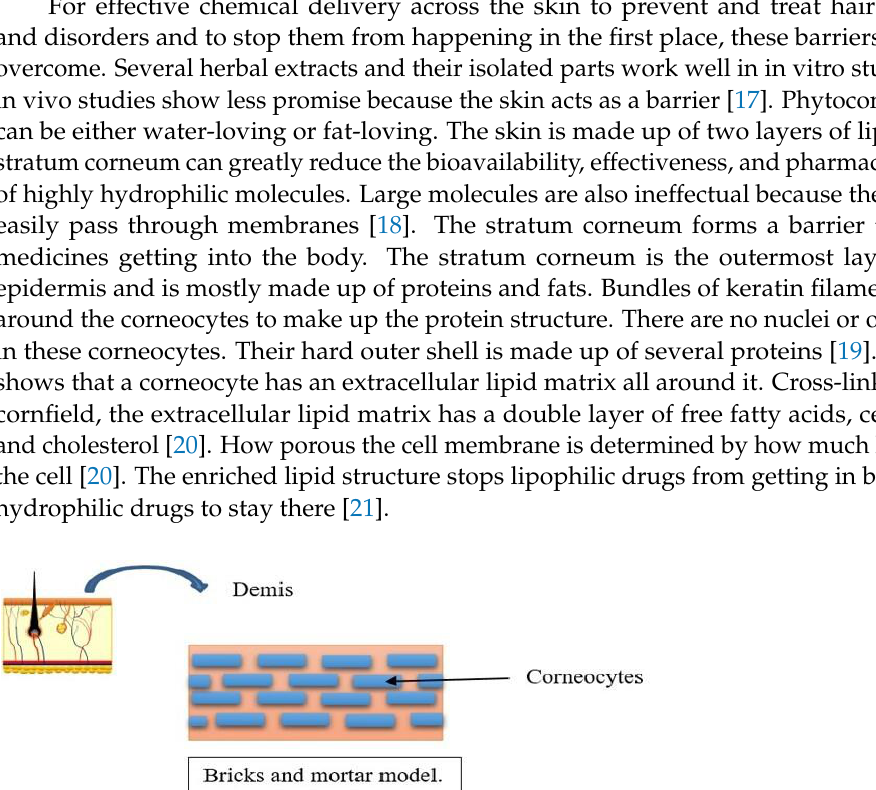
5 of 33 Figure 2. The Hair cycle “Reprinted with permission from Ref. [The hair cycle. Journal of cell sci- ence]. 2022, Alonso L, Fuchs E. et al. ” [16]. 2.3.2. Catagen Phase